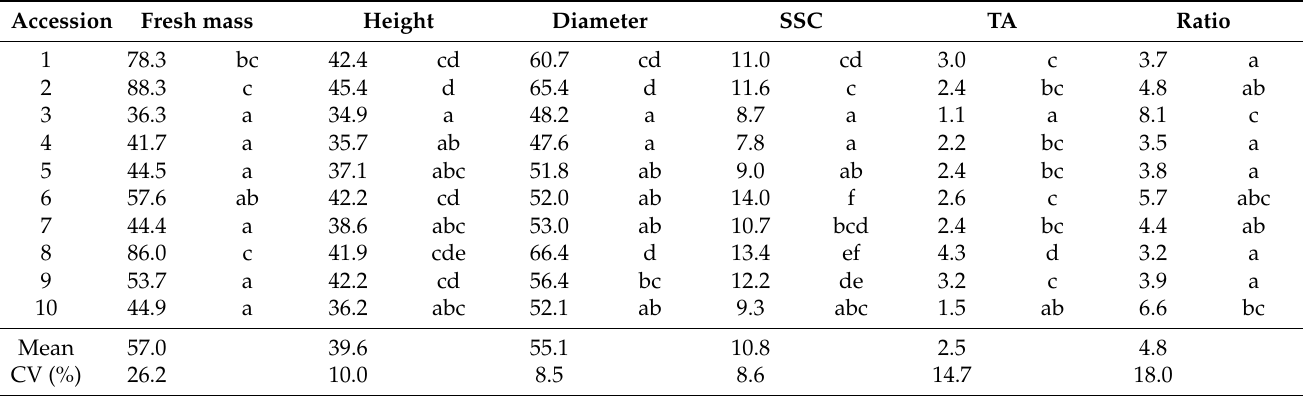
Table 1. Physicochemical cambuci quality